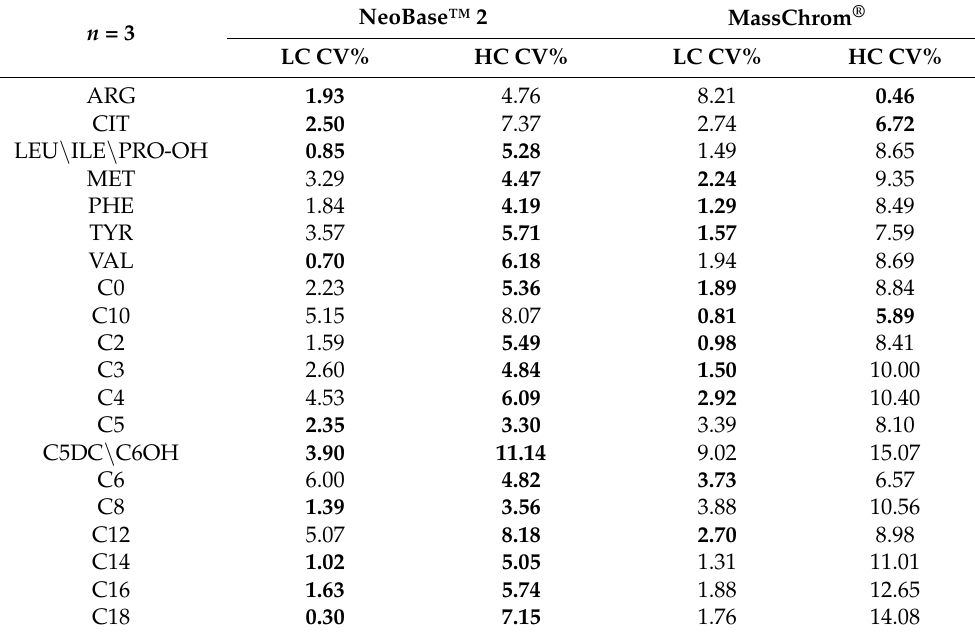
Table 3. Comparison of intra-day precision values from QC levels provided by manufacturers between NeoBase™ 2 and MassChrom ® non-derivatized kits on the RenataDX Screening System. For each analyte, the lower %CV value was highlighted in bold when comparing low and high QCs, respectively. NeoBase™ 2 n = 3